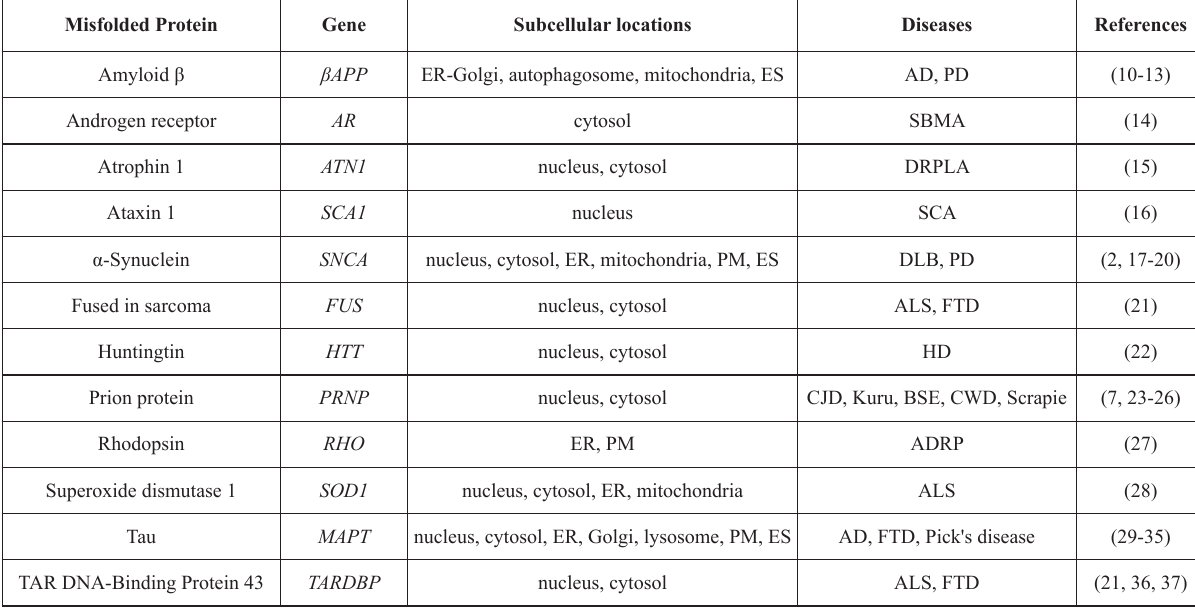
AD: Alzheimer disease; ADRP: Autosomal dominant retinitis pigmentosa; ALS: Amyotrophic lateral sclerosis; βAPP: amyloid β-protein precursor; BSE: Bovine spongiform encephalopathy; CJD: Creutzfeldt-Jakob disease; CWD: Chronic wasting disease; DLB: Dementia with Lewy bodies; DRPLA: Dentatorubral-pallidoluysian atrophy; ER: endoplasmic reticulum; ES: extracellular space; FTD: Fronto- temporal dementia; HD: Huntington's disease; MAPT: microtubule-associated protein tau; PD: Parkinson’s disease; PM: plasma membrane; SBMA: Spinal and bulbar muscular atrophy; SCA: Spinocerebellar ataxia; SNCA: Synuclein